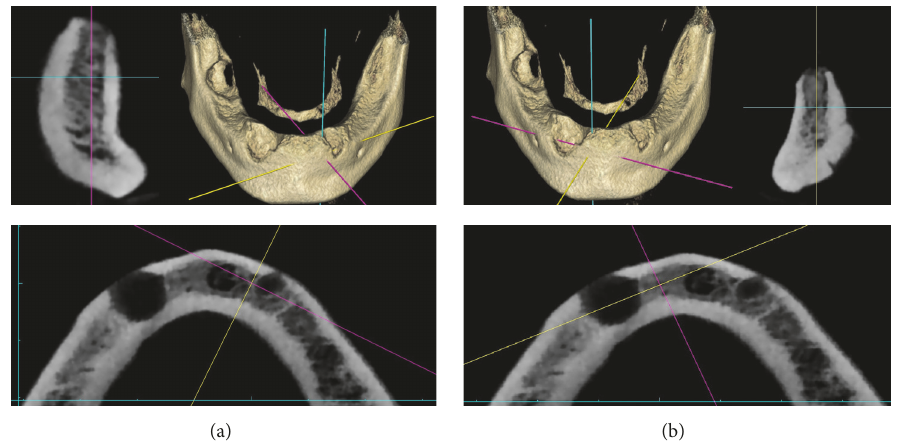
Figure 2: (a) Preoperative CBCT (cross-sectional and axial images) evaluation of the mandibular symphyses after dental extractions. Left mandibular position of the implant. (b) Preoperative CBCT (cross-sectional and axial images) evaluation of the mandibular symphyses after dental extractions. Right mandibular position of the